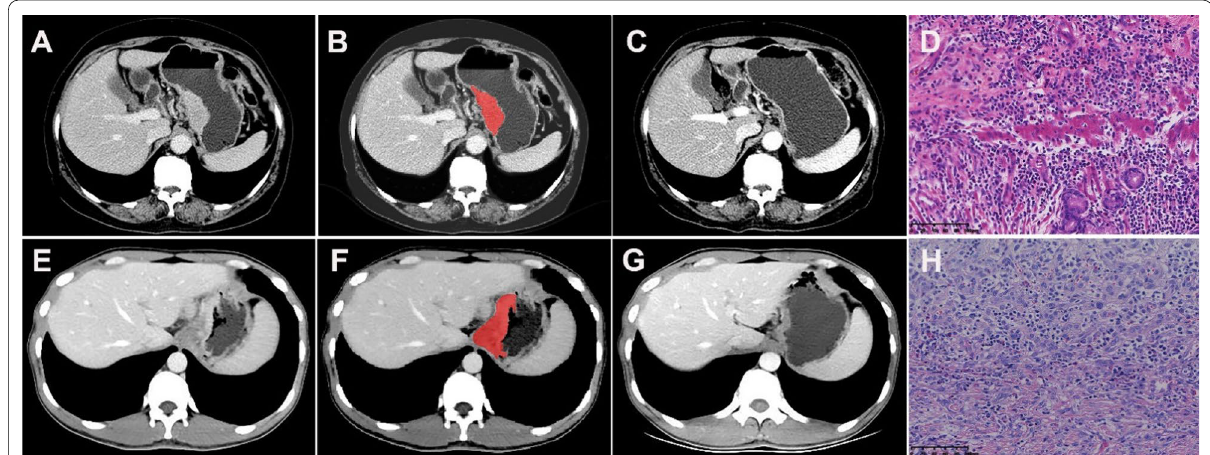
Fig. 1 Hypofractionated adenocarcinoma of the esophagogastric junction (AEG) in a 63-year-old man. A CT venous phase axial image before neoadjuvant chemotherapy (NAC), Borrmann staging type I, thickest tumor diameter of 3.4 cm. B Schematic diagram of region of interest (ROI) segmentation on ITK-SNAP software. C CT venous phase axial image after NAC, lesion near disappearance, and insignificant gastric wall thickening. D Postoperative pathological images; fibrous tissue hyperplasia with chronic inflammatory cell infiltration was seen; no tumor cells remained; and tumor regression was obvious (HE 200). Hypofractionated AEG in a 36 years old man. E CT venous phase axial image before neoadjuvant × chemotherapy (NAC), Borrmann staging type III, thickest tumor diameter of 3.2 cm. F Schematic diagram of region of interest (ROI) segmentation on ITK-SNAP software. G CT venous phase axial image after NAC, significantly smaller lesions with reduced enhancement. H Postoperative pathological images showed more chronic inflammatory cell infiltration in the mucosal and lamina propria layers with focal fibrosis (HE ×